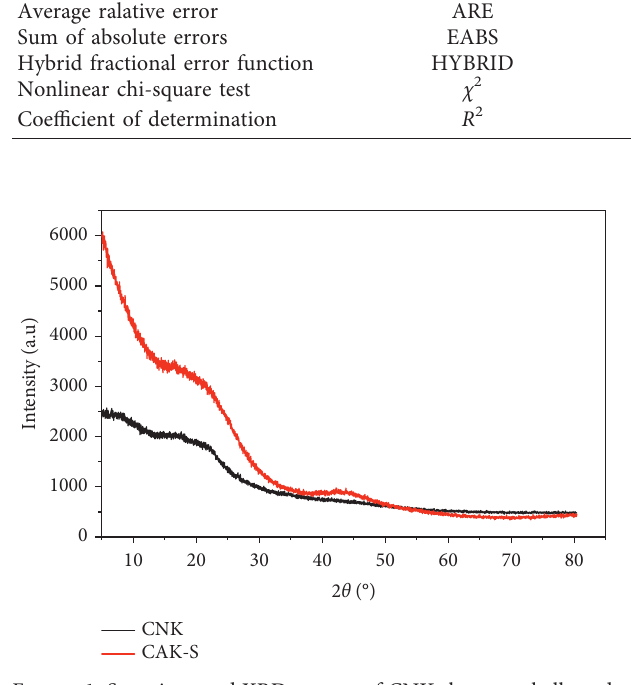
Figure 1: Superimposed XRD spectra of CNK shea nut shells and CAK-S activated carbon.